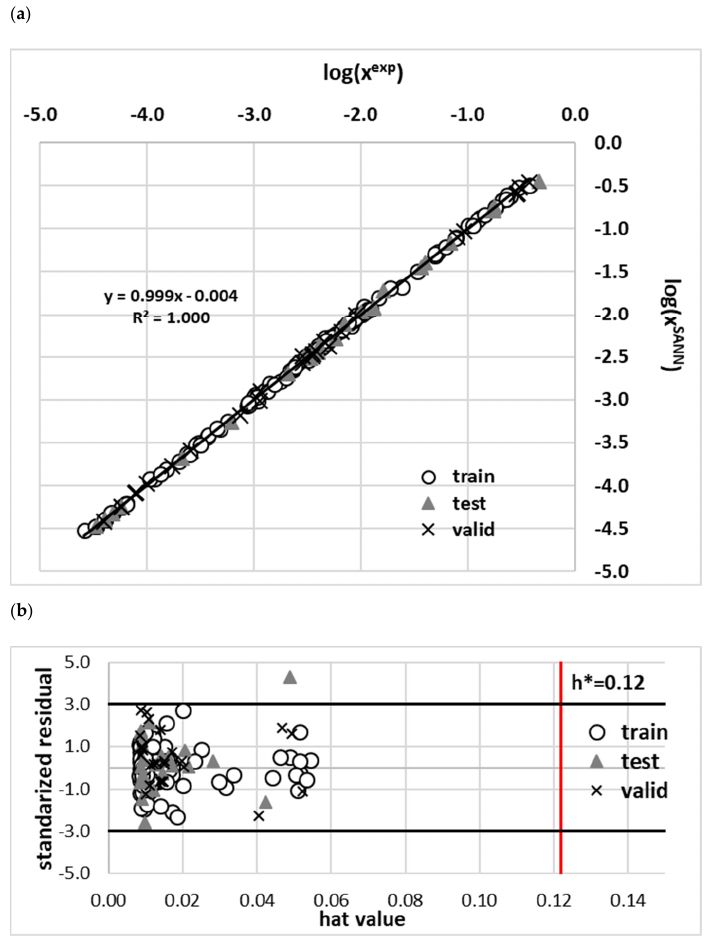
Figure 6. Representative example of sulfamethizole solubility prediction using one of the neural networks included in the developed ensemble of SANNs (top panel a) along with the applicability domain (bottom panel b) for 175 data points.